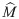

M^ is shown for Case 2 of the proof of Lemma 12.